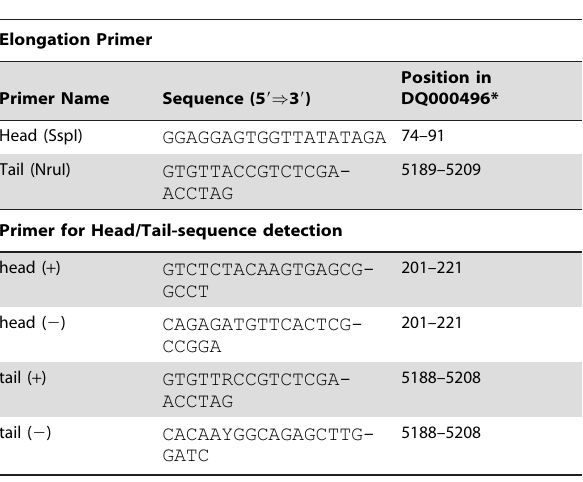
Table 2. Overview on primers used in this study.